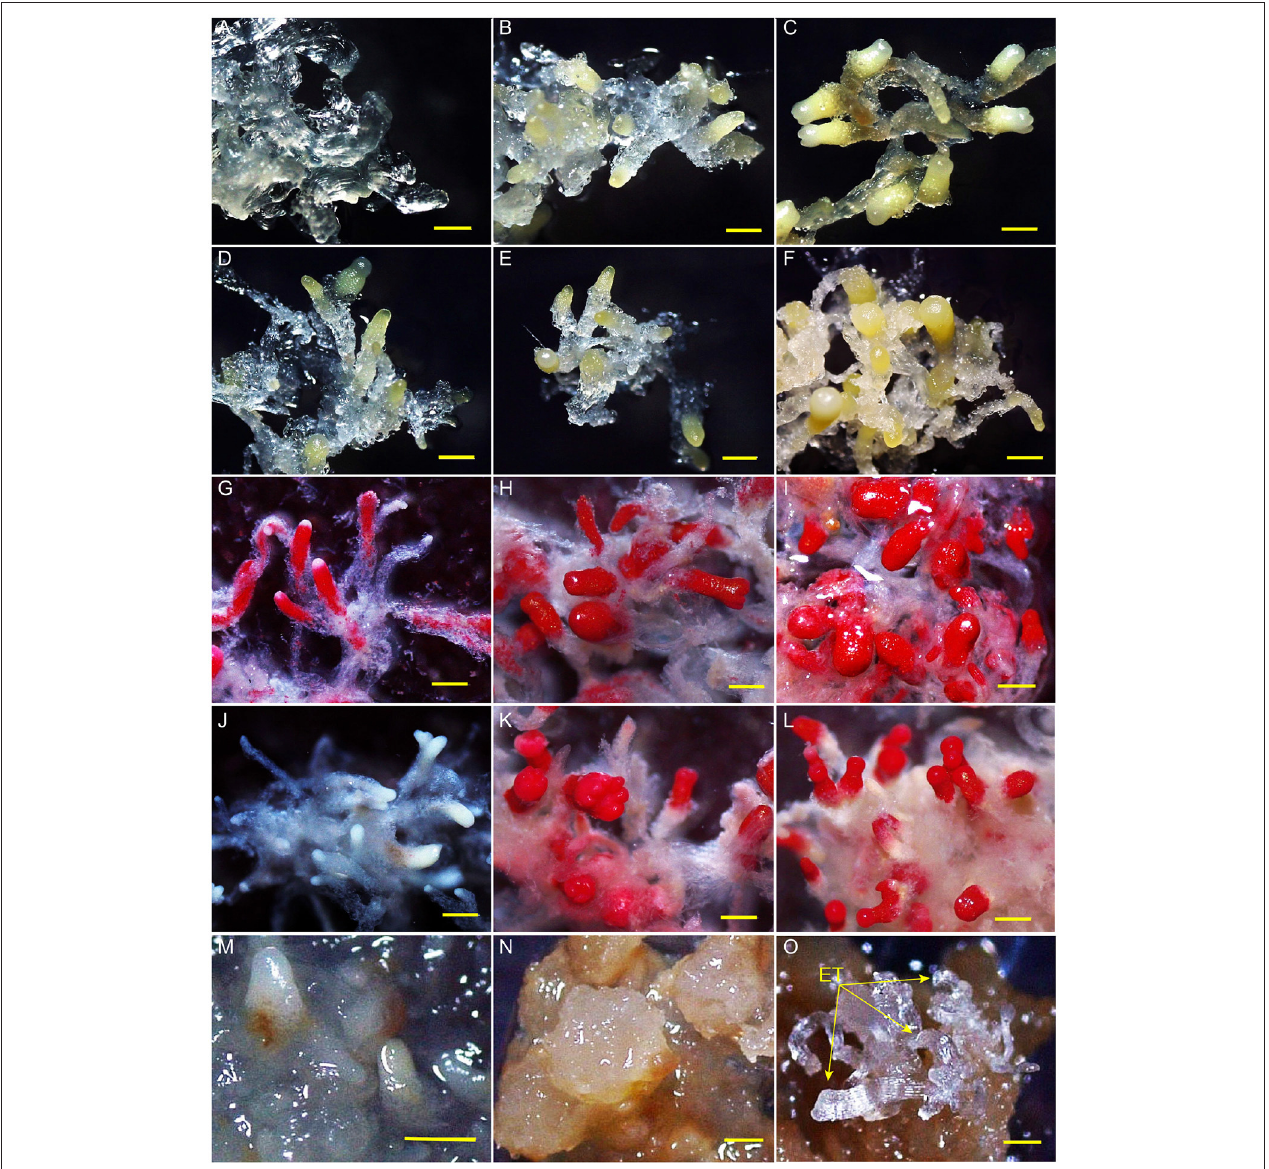
FIGURE 1 | Somatic embryos after various treatments. Development of somatic embryos on maturation medium under 23 ◦ C for 0, 2, and 4 weeks were, respectively shown in (A–C) . The immature somatic embryos that were cultured on maturation medium at 23 ◦ C for 2 weeks and then at 4 ◦ C for 2, 4, and 10 weeks were each shown in (D–F) . TTC assay of the tissue of MMA2, MMA4 and MCA10 before liquid nitrogen (LN) treatment were, respectively shown in (G–I) , and the corresponding results for the tissues after LN treatment were shown in (J–L) . Embryogenicity of the tissue of MMA2, MMA4 and MCA10 after LN treatment were, respectively shown in (M–O) . The arrow indicates newly re-initiated embryogenic tissue (ET). All bars = 500 µ